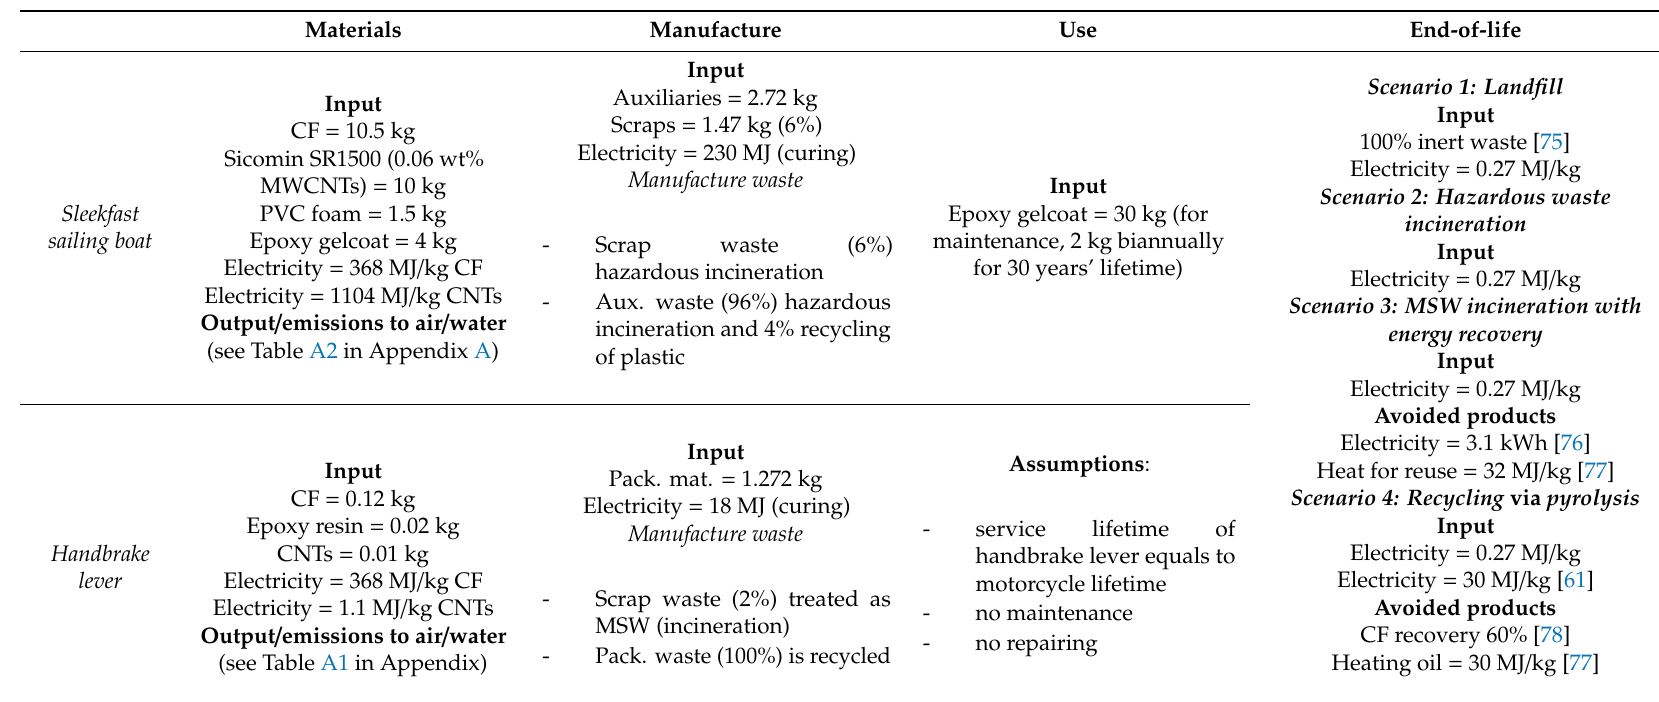
Table 2. Aggregated inventory per life cycle stage and related assumptions *. CF, carbon fibre; MWCNT, multi-walled carbon nanotube; MSW, municipal solid